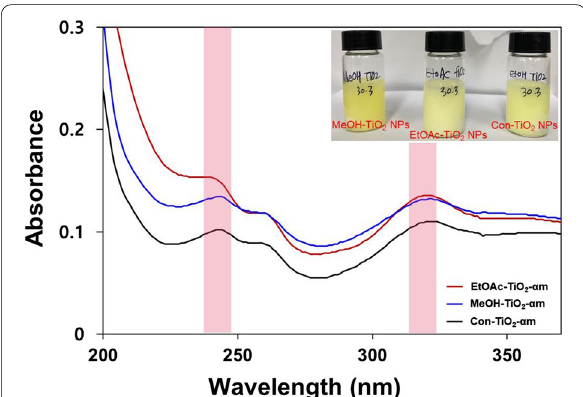
Fig. 5 UV–visible spectra of the functionalized TiO 2 NPs. The black, red and blue lines indicate Con‑TiO 2 ‑αm, EtOAc‑TiO 2 ‑αm and MeOH‑TiO 2 ‑αm. The inset shows digital photography of each colloidal solution of MeOH‑TiO 2 ‑αm (left image), EtOAc‑TiO 2 ‑αm (middle image) and Con‑TiO 2 ‑αm (right